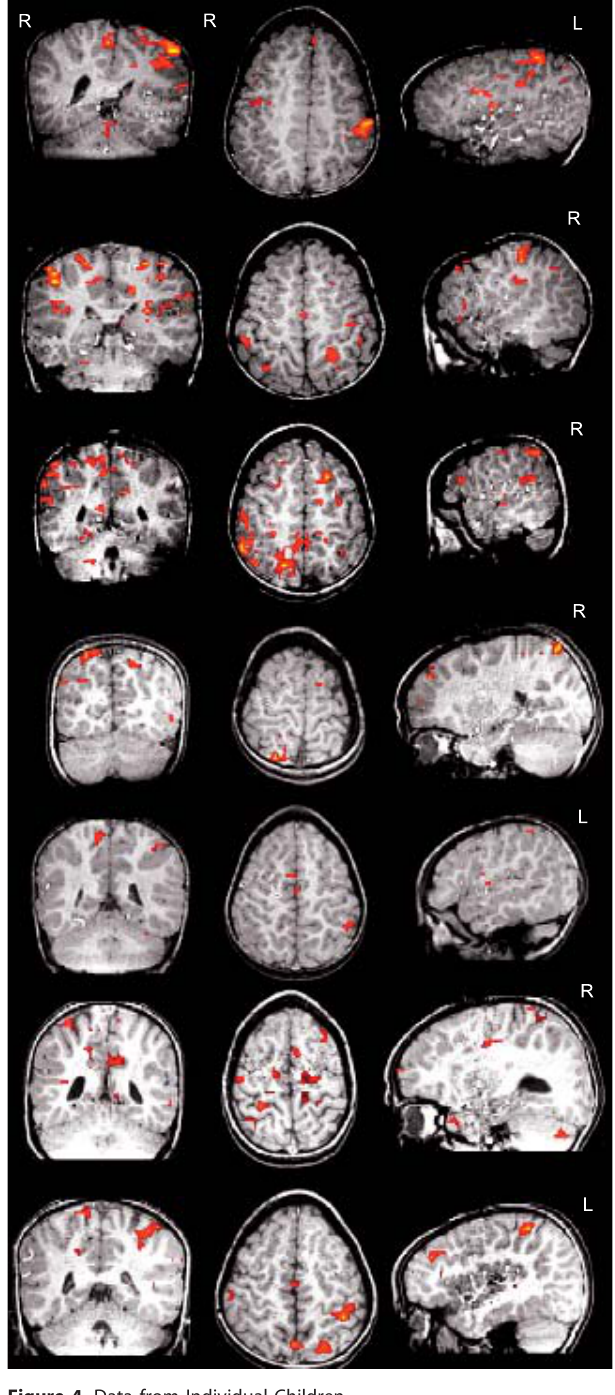
Figure 4. Data from Individual Children Each row presents an individual participant’s activation map indicating regions that were more active during the presentation of number compared to shape deviants ( p , .05, cluster size . eight functional voxels) overlaid on that child’s own anatomical images. One child moved during the anatomical scan (which occurred after the functional scan) and is thus not included in this